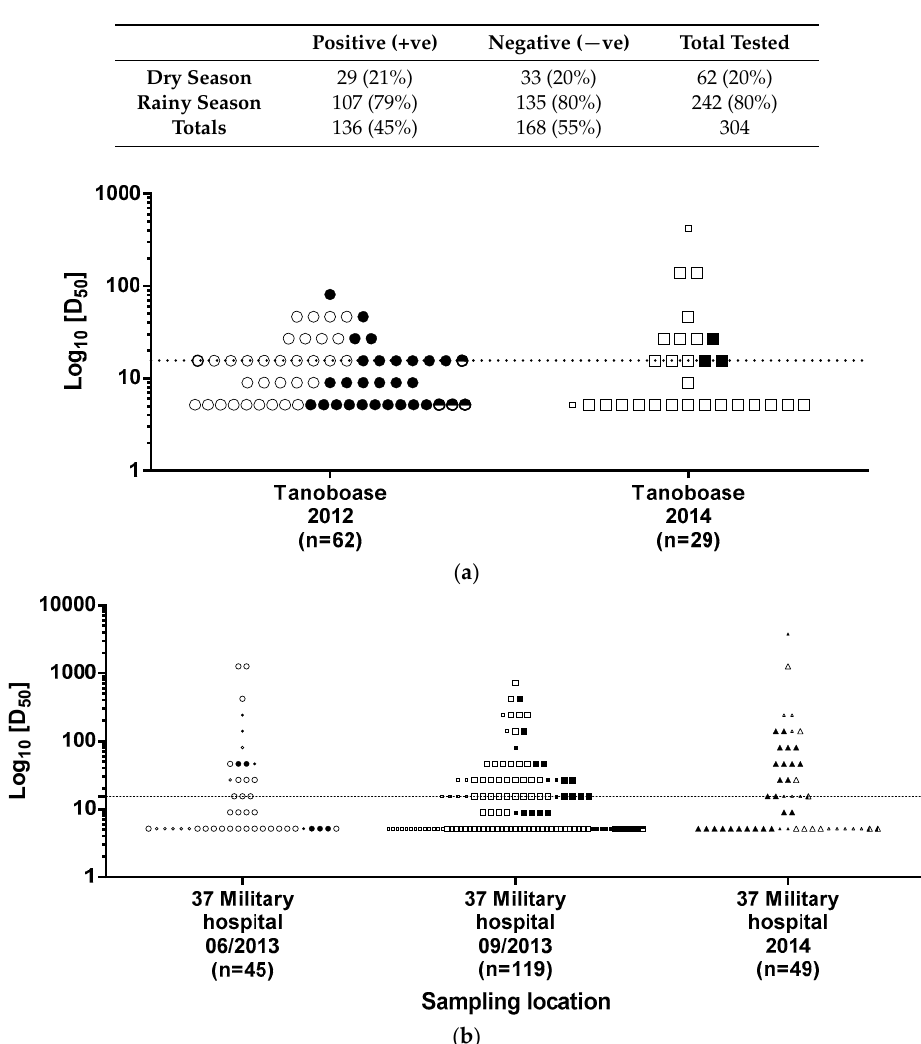
Table 3. Proportion of seroprevalence in wild-caught bats by season.